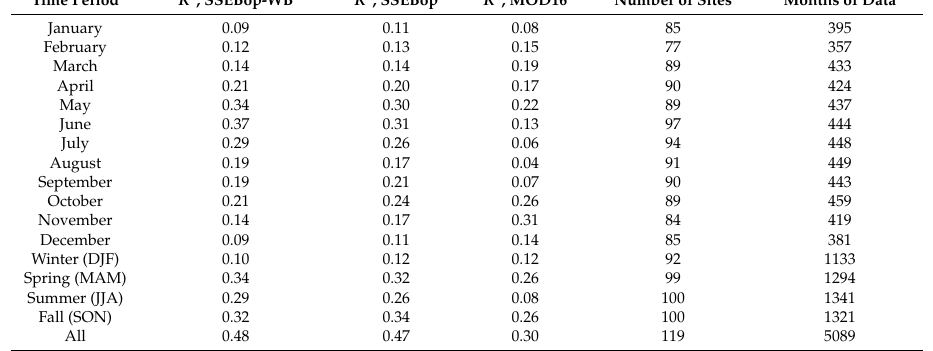
Figure 8. AmeriFlux data comparison at monthly time scale. AmeriFlux ET data ( x -axes) are compared with ( a ) SSEBop-WB ET; ( b ) SSEBop ET; and ( c ) MOD16 ET.